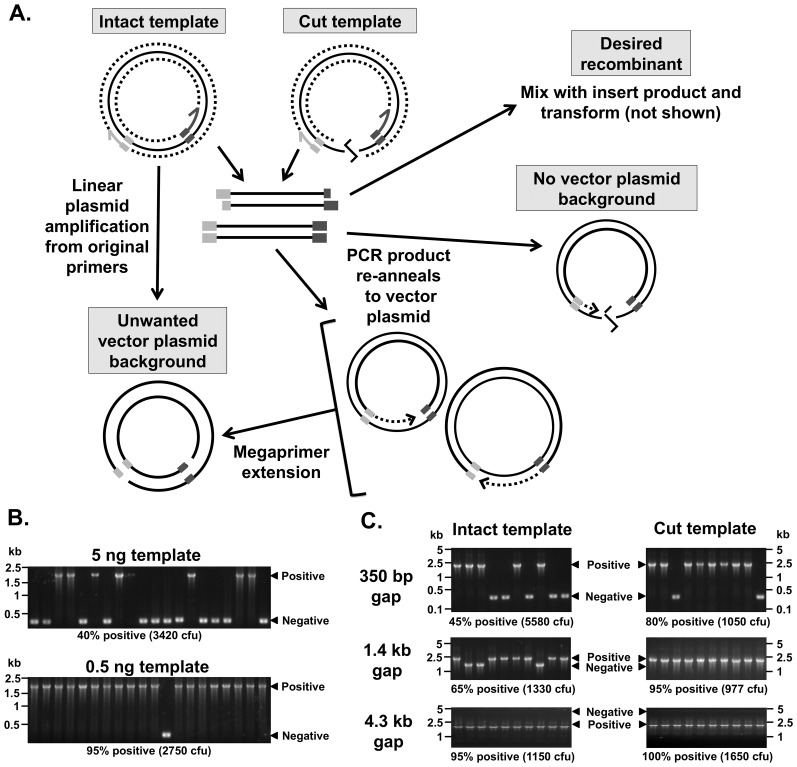
Generation of nicked vector plasmid can reduce PIPE cloning efficiency.Unwanted copies of the original vector plasmid template can be generated by overlap extension in the process of obtaining vector-backbone PCR product (A). This can be prevented by reducing the template concentration (B), cutting the plasmid template first or cloning into a vector with an existing large insert (C). See main text for details.